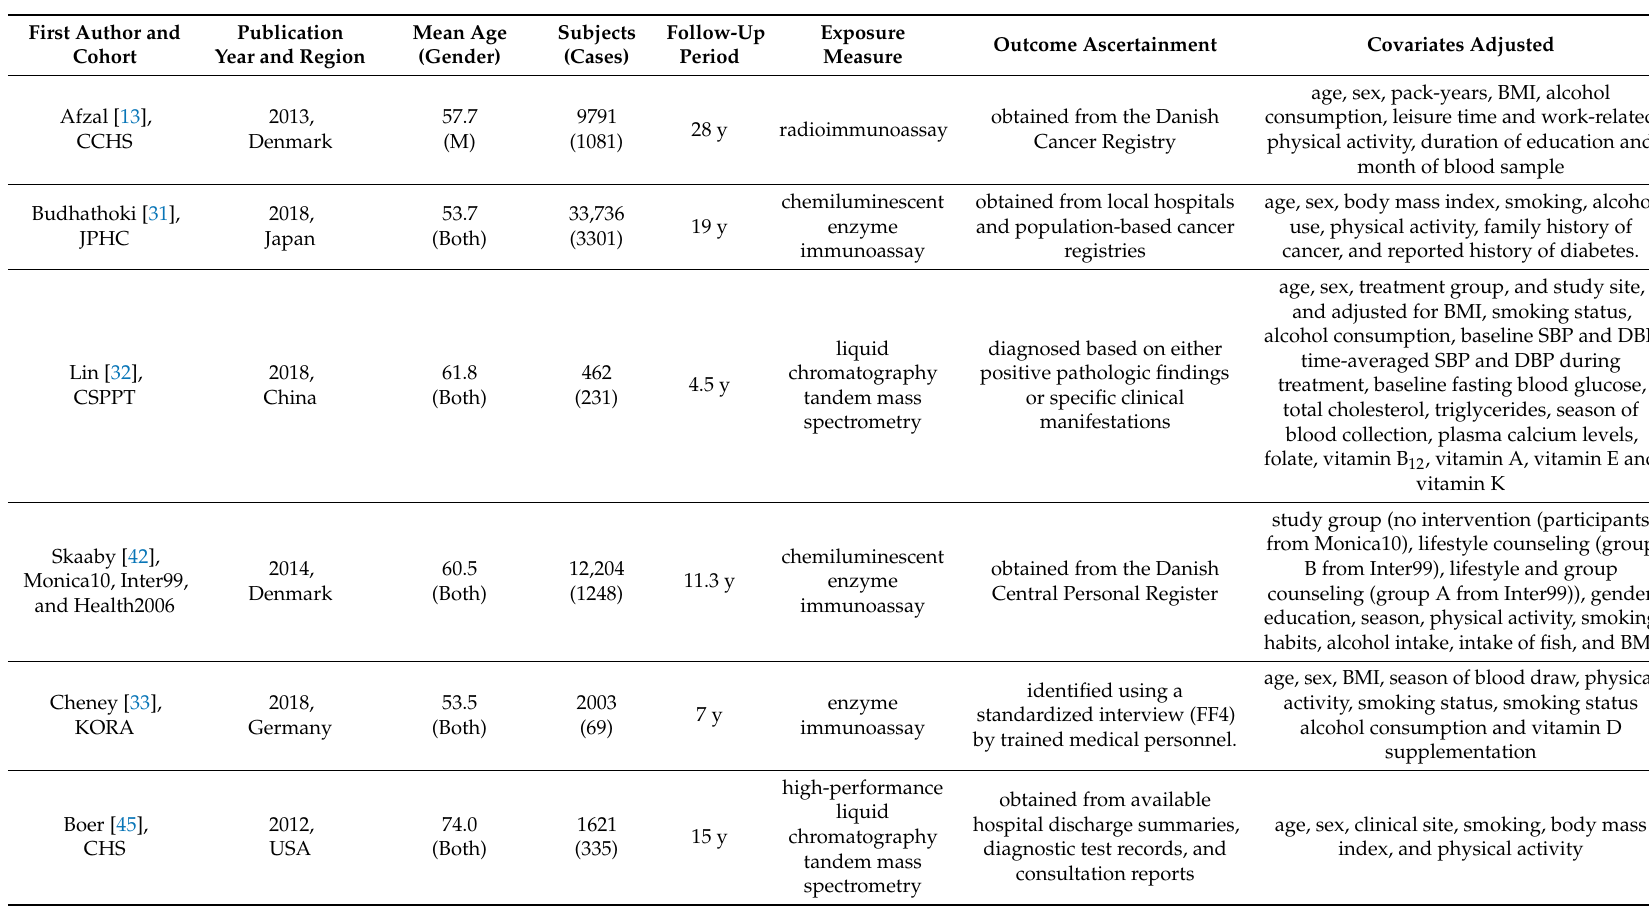
Table 1. Prospective studies reporting on the association of circulating 25(OH)D serum concentration with total cancer incidence